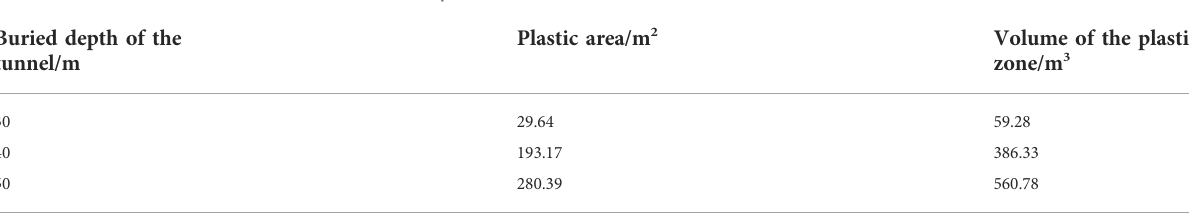
TABLE 6 Plastic area and volume at different burial depths.